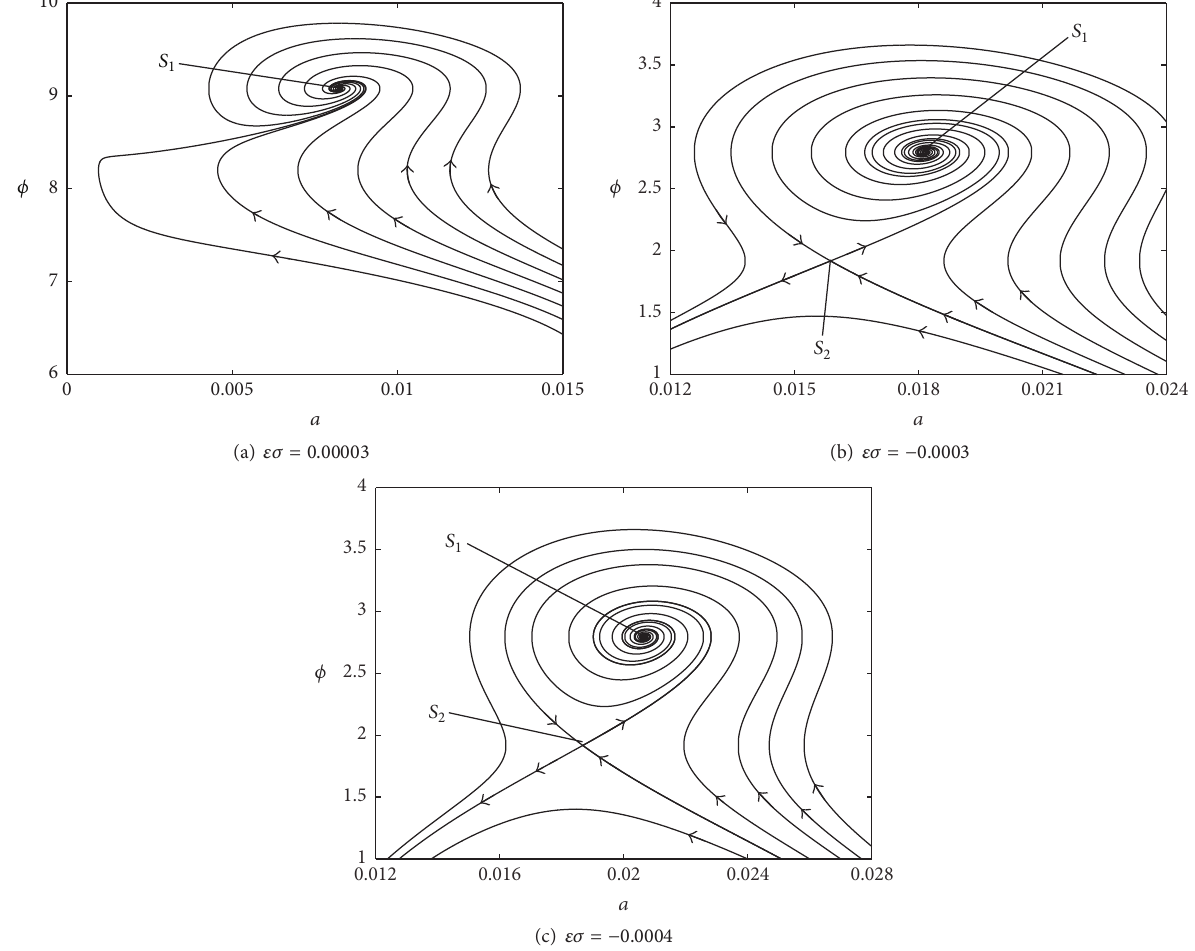
Figure 8: The phase plane curves.